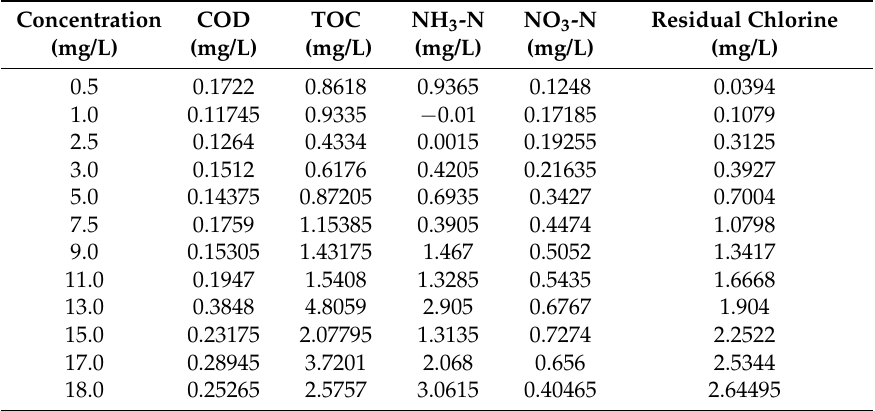
Table 4. Real concentrations and relative responding values in the test set.